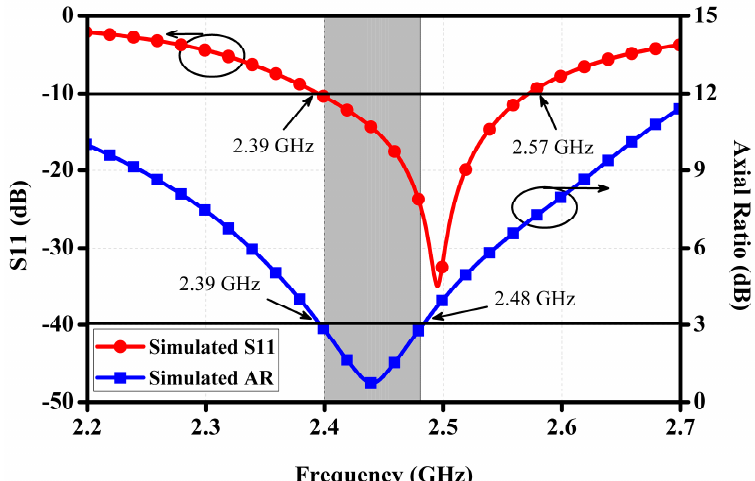
Figure 3. Simulated reflection coefficient and axial ratio (AR) varying with frequency.